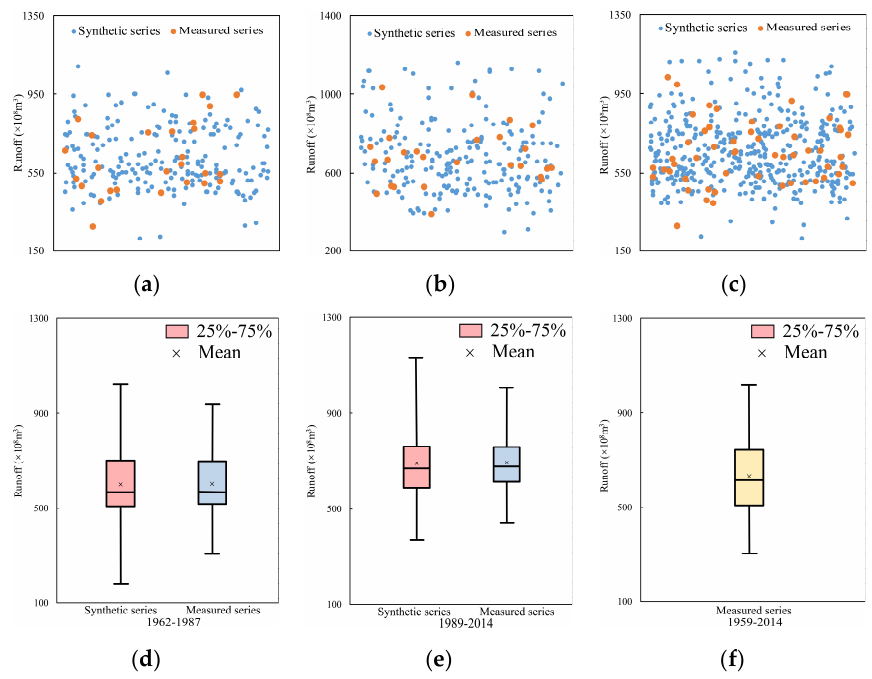
Figure 17. Scatter diagram ( a , b ) and boxplots ( d , e ) of synthetic series and measured series in two segments at Xiangtan gauge; ( c ) a scatter diagram of all the synthetic data and the whole original measured data; ( f ) the boxplots of the whole series.